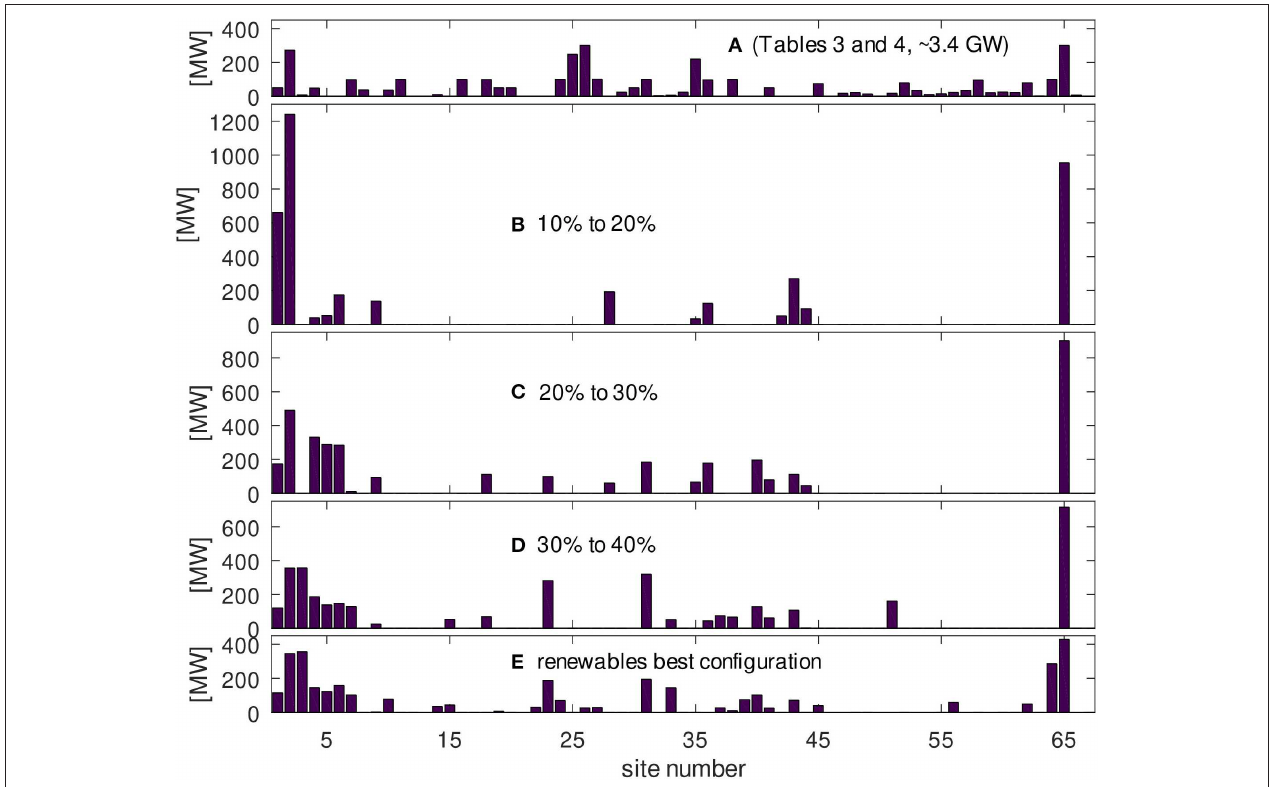
FIGURE 5 | Power capacity distribution of sites. (A) Installed and project capacity detailed in Tables S2 , S3 (3.4 GW); (B) 4.0 GW added capacity to reach 20% in energy share; (C) 3.7 GW added capacity to reach 30% share; (D) 3.45 GW to reach 40%; (E) renewables configuration with least dispersion, rescaled to achieve 10% of electricity load during 2015–2016 (3.4 GW).